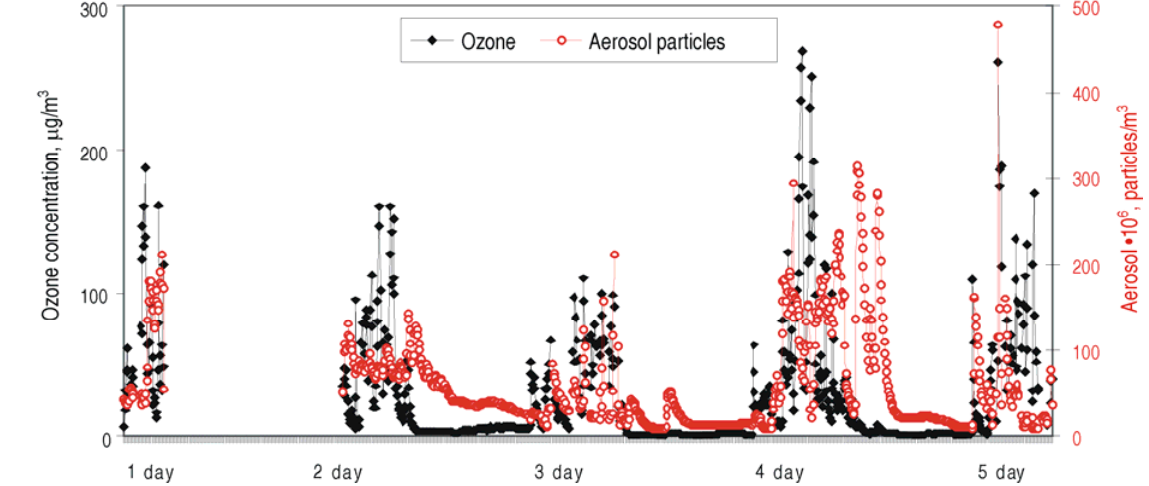
Fig. 1. Dynamics of ozone and aerosol particle concentrations in the workroom, January 8–12,